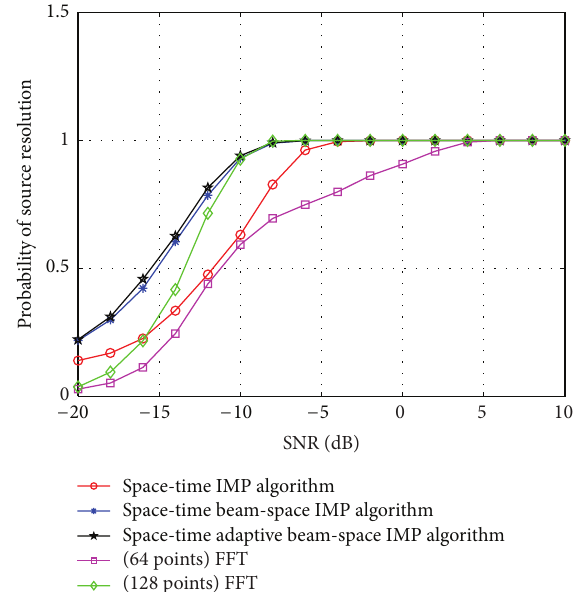
Figure 2: Doppler estimated RMSE versus SNR.